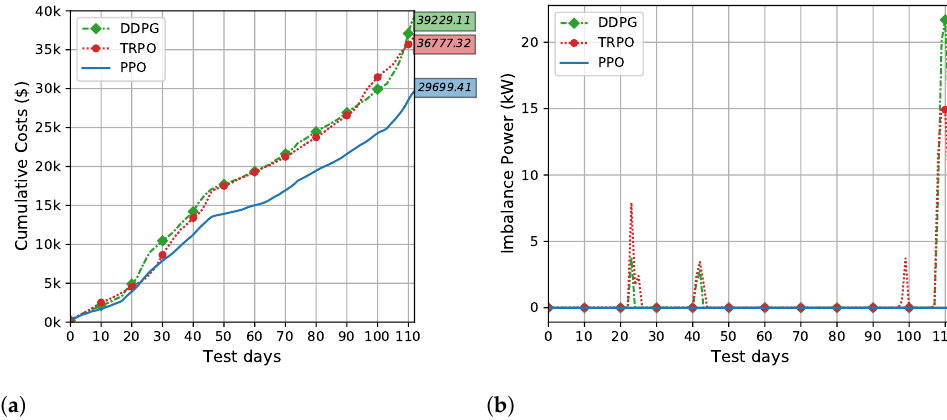
Figure 7. Testing performance of DDPG, TRPO, and the proposed approach (PPO). ( a ) Cumulative operating costs on 113 testing days; ( b ) Total imbalance power on each testing